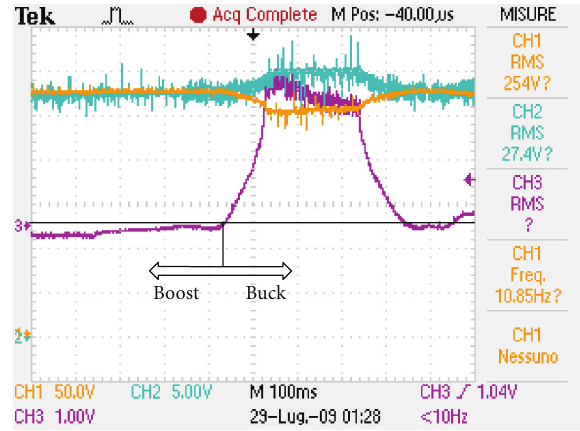
Figure 22: Transition buck to boost in buffer experimental test. Figure 23: Transition boost to buck in buffer experimental